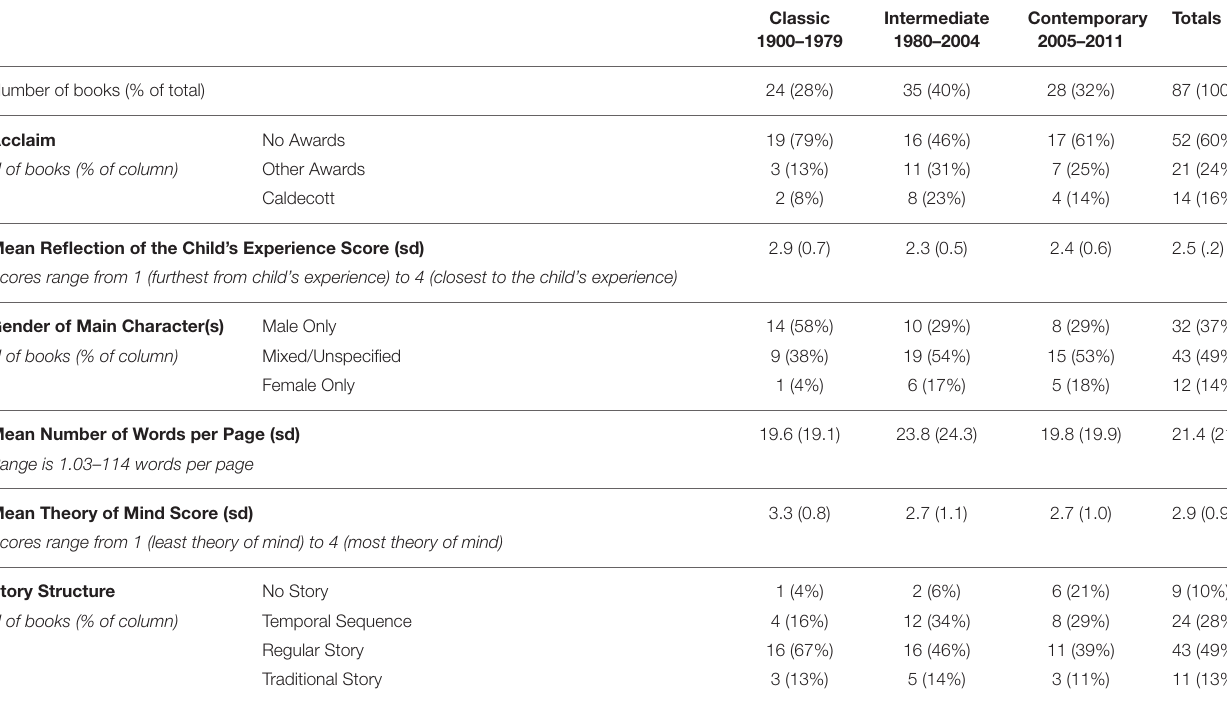
TABLE 1 | Summary of the sample of books